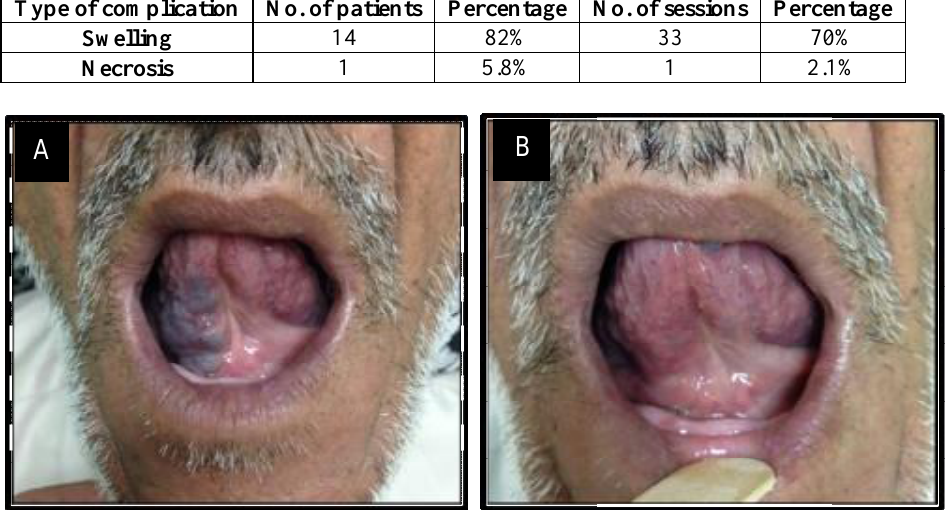
Table 4: Relation between No. of patients, No. of sessions, and complications Type of complication